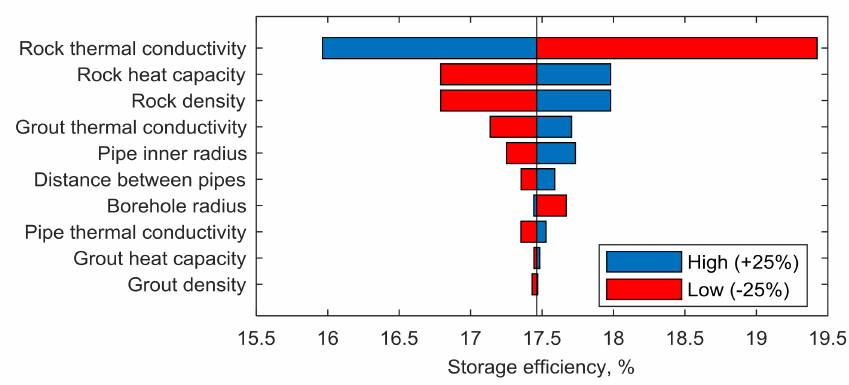
Figure 14. Sensitivity analysis of the storage efficiency after 21 days of charging and 21 days of constant discharging versus a ± 25% change in the selected model